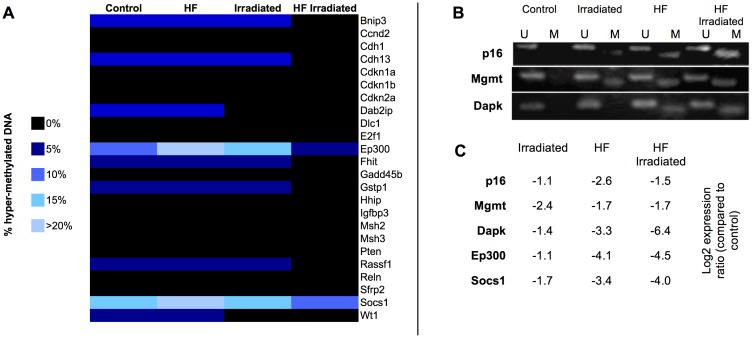
Gene promoter methylation in C57BL/6J mouse livers.A: Heatmap representing the promoter methylation status for 24 liver cancer-related genes in the livers of non-irradiated and irradiated C57BL/6J mice fed a normal or HF diet. B: Representative gels showing the methylation-specific PCR analysis of the promoter methylation status for p16, Mgmt and Dapk genes.